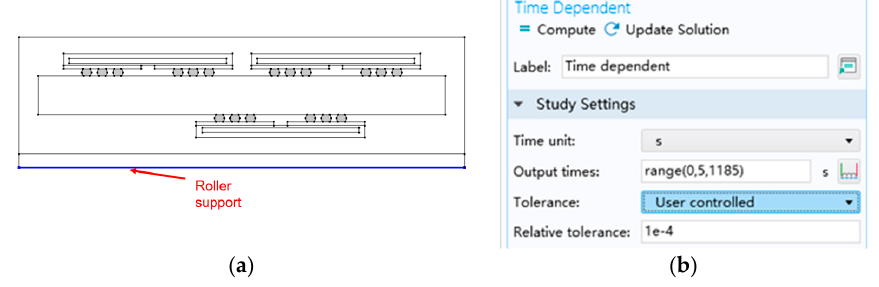
Figure 6. The settings of ( a ) boundary constraint; ( b ) finite element analysis.